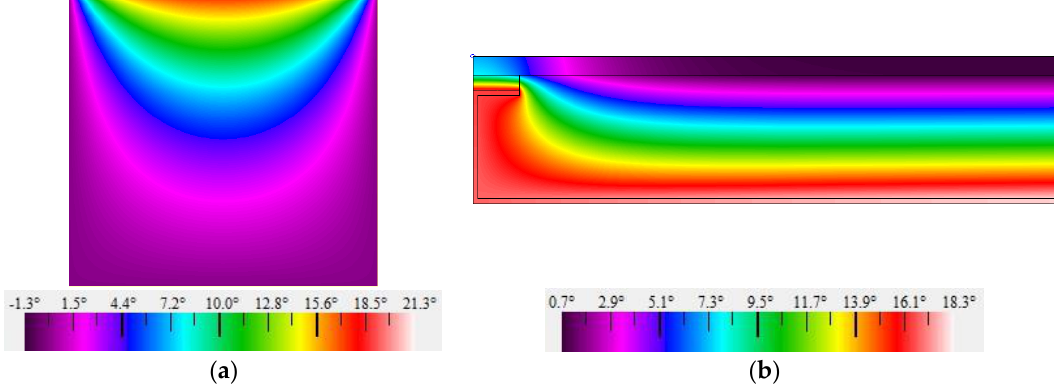
Figure 4. Temperature distribution obtained for the 2D test cases of EN ISO 10211 [26]: ( a ) Test Case 1; ( b ) Test Case 2.